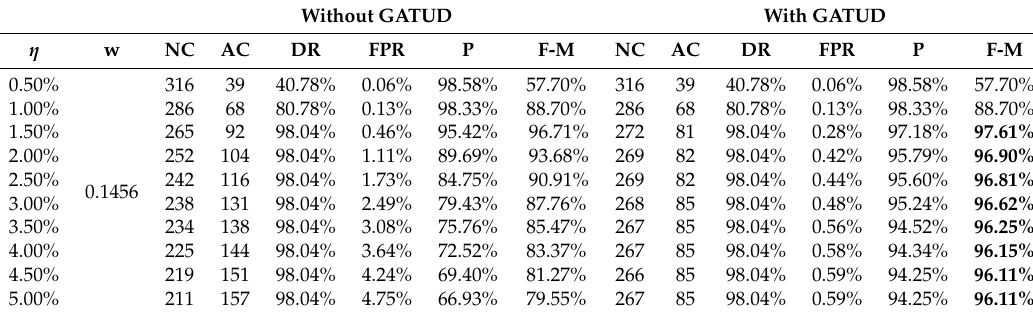
Table 10. The detection accuracy of the proximity-detection rules that have been extracted with/without the integration of GATUD in the separation process on SimData1.